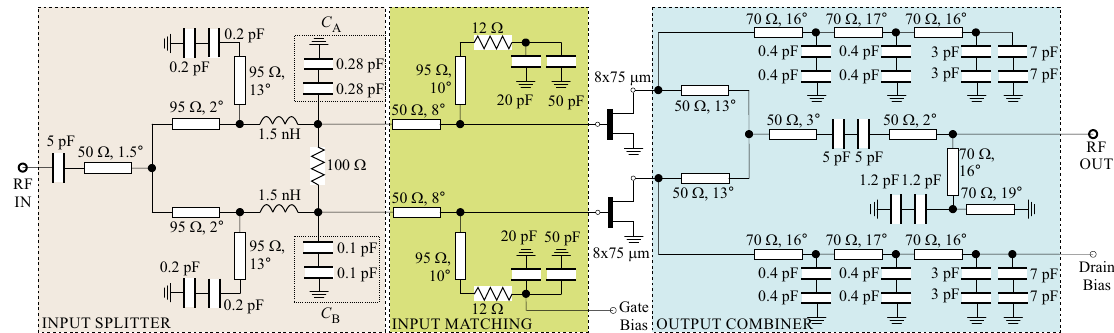
Figure 1. Complete scheme of the Tuned Load Amplifier. Equivalent ideal lines are represented: electrical length refers to 7 GHz.